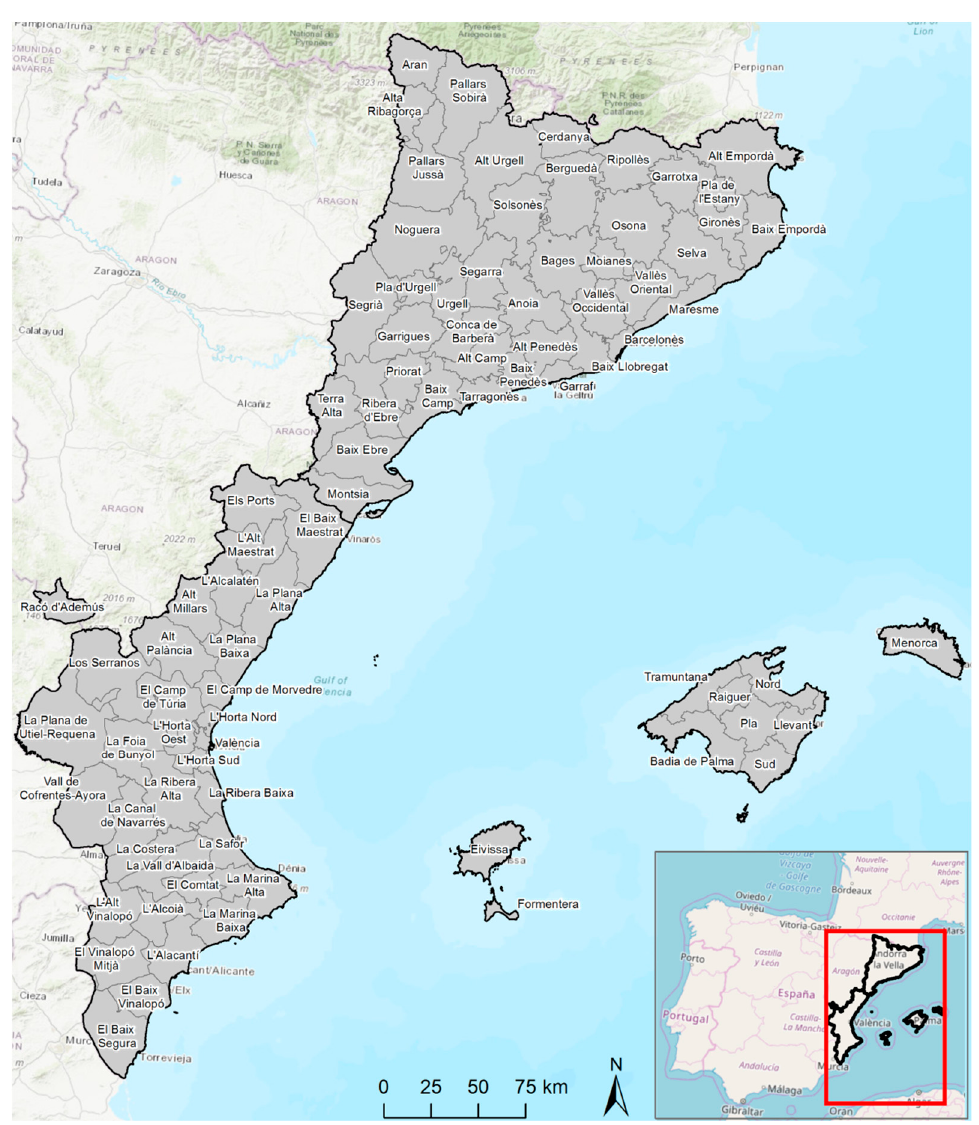
Figure 1. Study area, and the boundaries of the districts.